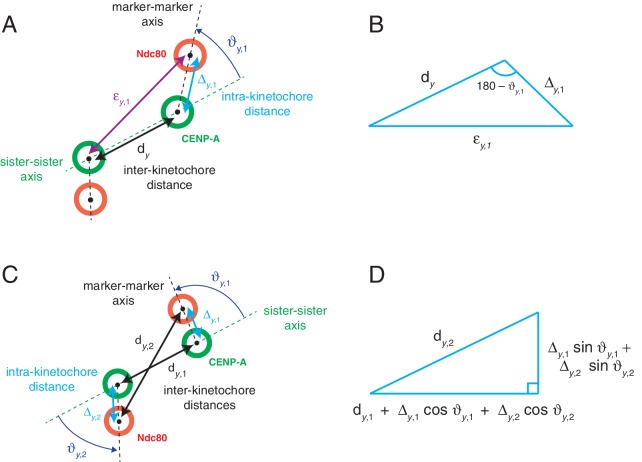
Measurement of axial swivel, and characterisation of 1D delta’s underestimate of 3D delta.(A) Schematic of a kinetochore’s inner (CENP-A; green circles) and outer domain (Ndc80; red circles) markers relative to its sister in the xy-plane. Green and black dashed lines represent sister-sister and marker-marker axes, respectively. Measurements shown are the inter-kinetochore distance (dy; black), intra-kinetochore distance (Δy,1; light blue), and a third distance measurement, εy,1(defined as the distance between a kinetochore’s outer domain marker and its sister’s inner domain marker; purple), and kinetochore swivel (ϑy,1; dark blue). (B) The triangle formation used to measure axial swivel of a kinetochore. (C) Schematic of a kinetochore pair, as in (A), however both inner-inter-kinetochore (dy,1; between inner domain markers) and outer-inter-kinetochore (dy,2; between outer domain markers) are shown. (D) The triangle formation used to calculate the underestimate of 3D intra-kinetochore distance using 1D measurements.